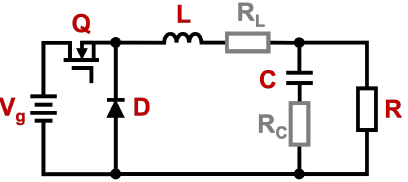
Figure 7. Buck converter equivalent model with capacitive and inductive parasitic elements.